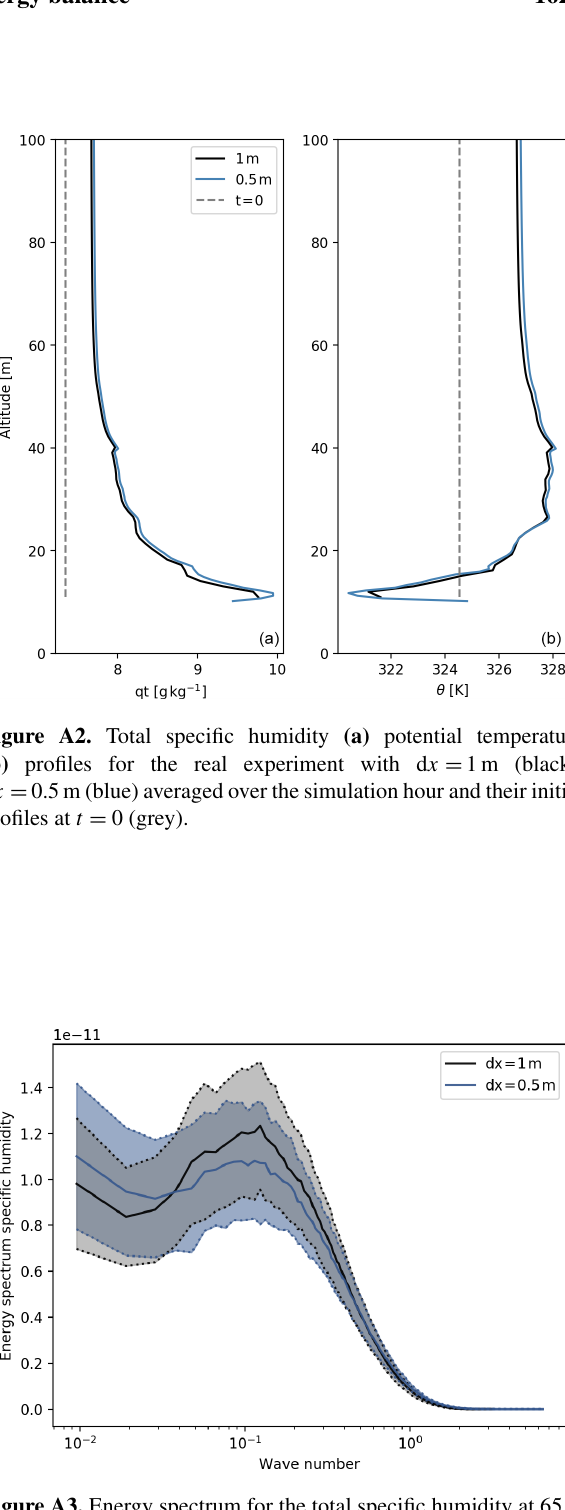
Figure A3. Energy spectrum for the total specific humidity at 65m above lowest point of the topography, averaged over the simulation hour. Shading indicates 1 standard deviation. The vertical axis is premultiplied with the wave